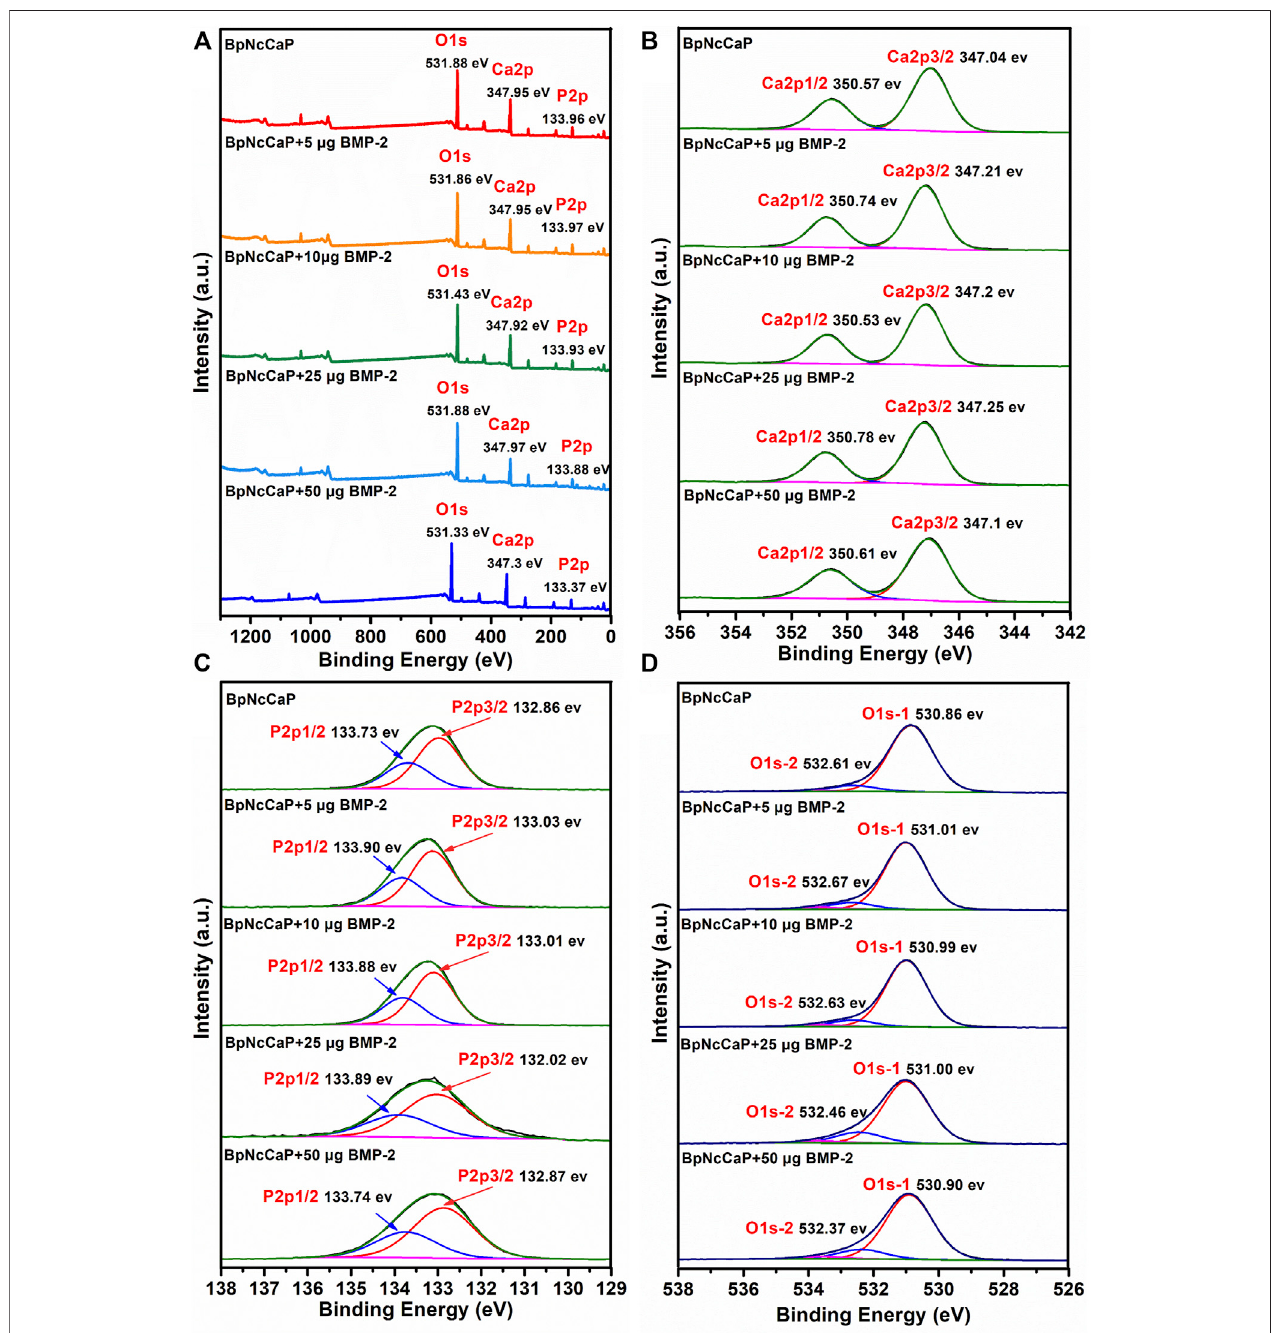
FIGURE 5 | Total XPS survey spectra (A) , XPS spectra of Ca 2p (B) , XPS spectra of P 2p (C) and XPS spectra of O 1s (D) for BpNcCaPs without or with different amounts (5/10/25/50 μ g) of BMP-2.